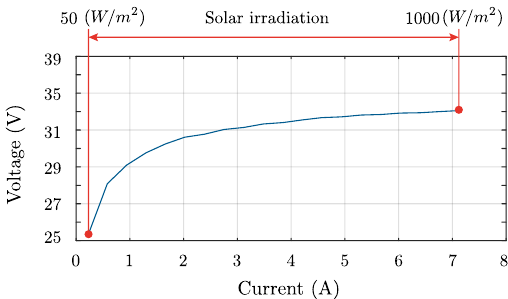
Figure 5. PV voltage variation in terms of the PV current variation under different solar irradiation.